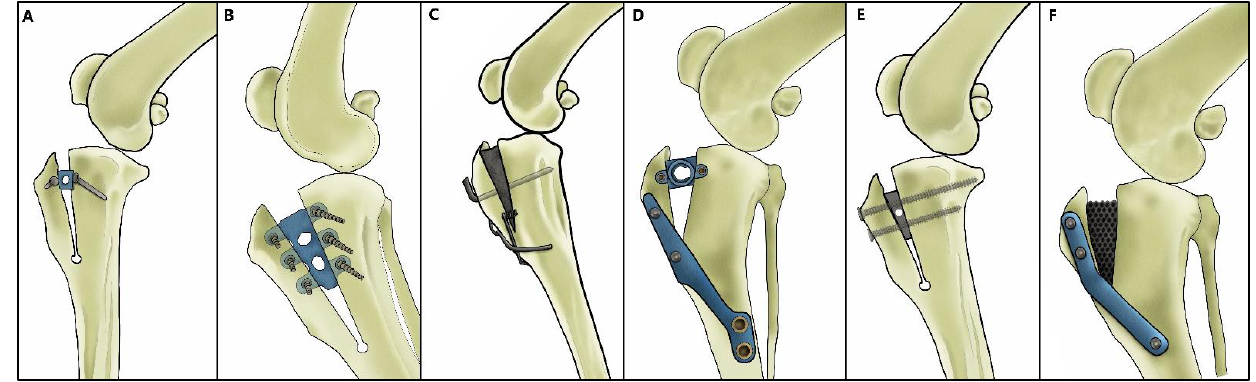
Figure 1. Graphic illustrations of TTAT included: ( A ) modified Maquet technique (MMT), ( B ) TTA rapid, ( C ) modified Maquet procedure (MMP), ( D ) modified Maquet tibial tuberosity advancement (mTTA), ( E ) tibial tuberosity advancement with cranial fixation (TTA-CF) and ( F ) porous TTA (designed by Claudio Palumbo).